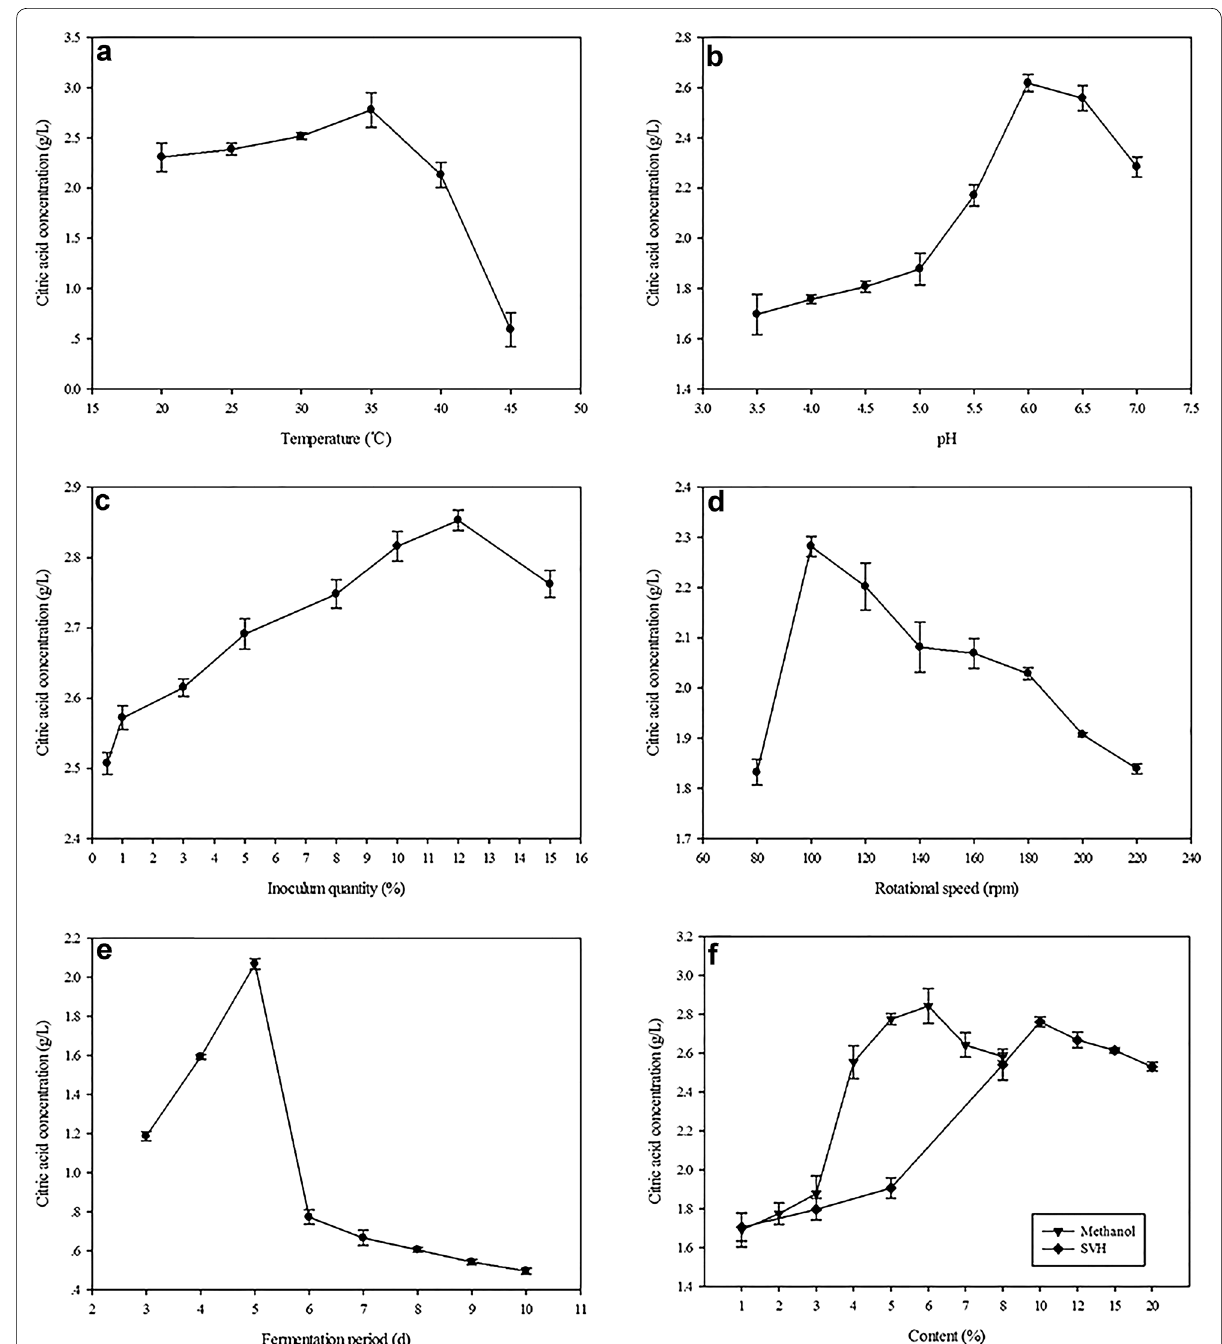
Fig. 1 Single-factor optimization of fermentation condition: a – e effects of temperature, pH, inoculum quantity, rotational speed, fermentation period, and f the content of methanol and SVH on citric acid concentrations,